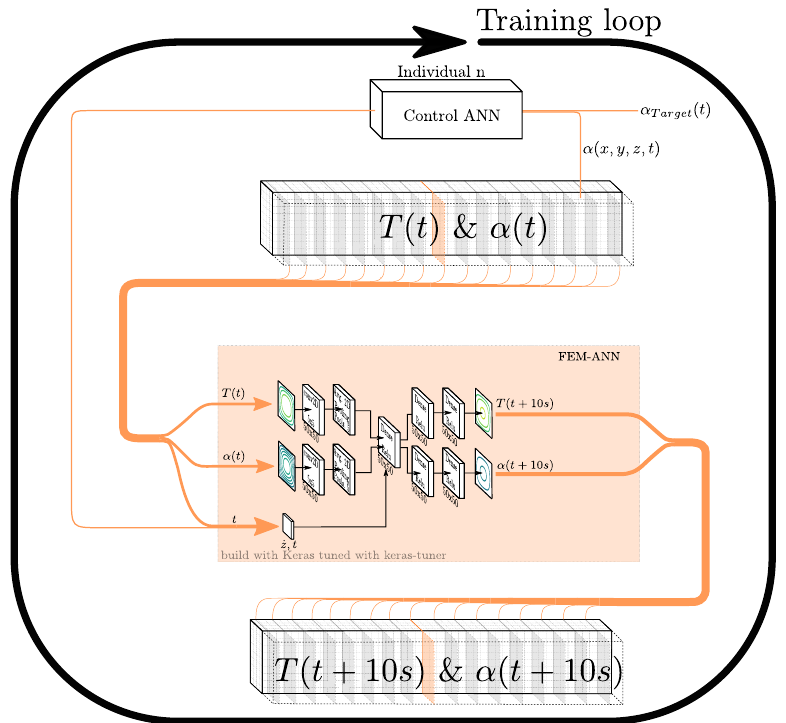
Figure 5. ANN-Training